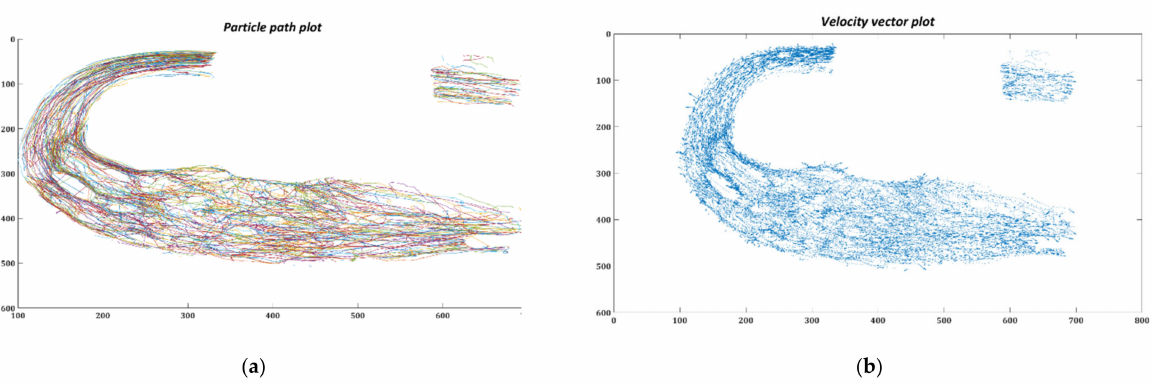
Figure A1. Patient 1 ( a ) Trajectory of the particles ( b ) Flow field of the particles in the MPA conduit.